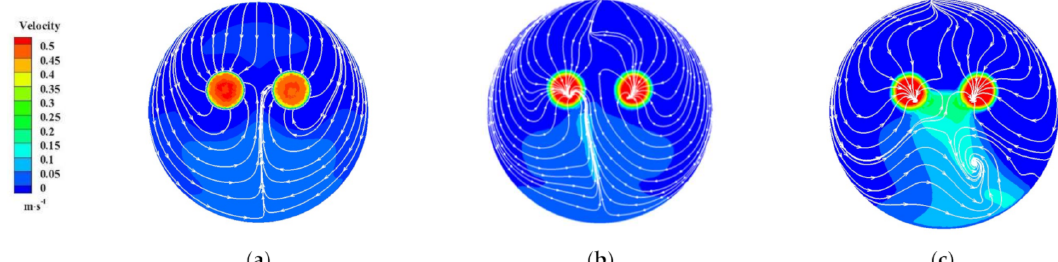
Figure 16. Streamline and velocity nephogram of Section 4-4 of the sump under different H values: ( a ) H = 0.3 D ; ( b ) H = 0.6 D ; ( c ) H = 0.9